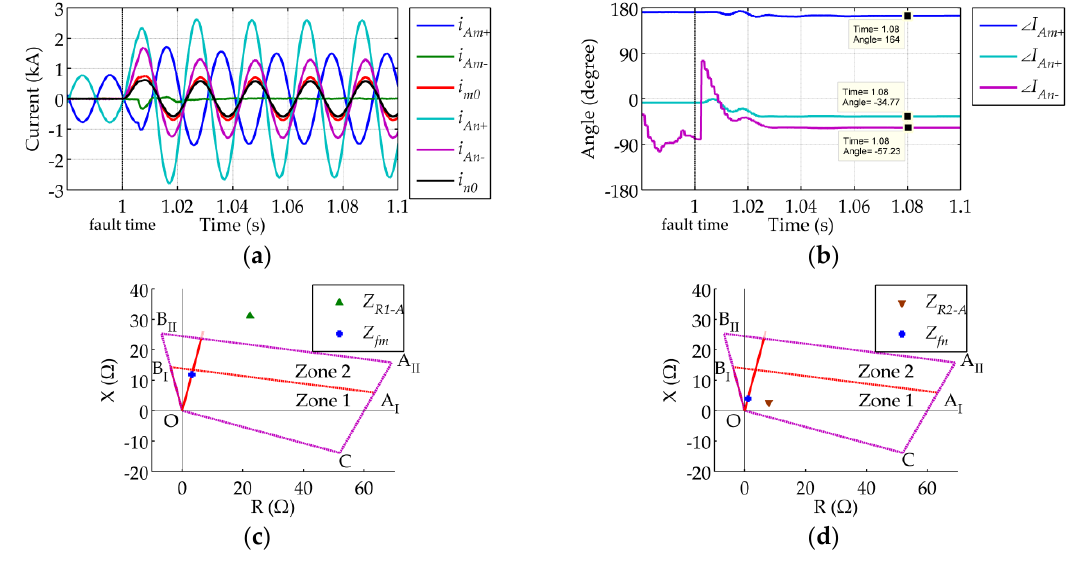
Figure 17. Sequence components of the fault currents and measured impedances in Case 2: ( a ) The sequence components of the currents flowing through R1 and R2; ( b ) Phase angles of the sequence components; ( c ) Measured impedance of the AG element in R1; ( d ) Measured impedance of the AG element in R2.